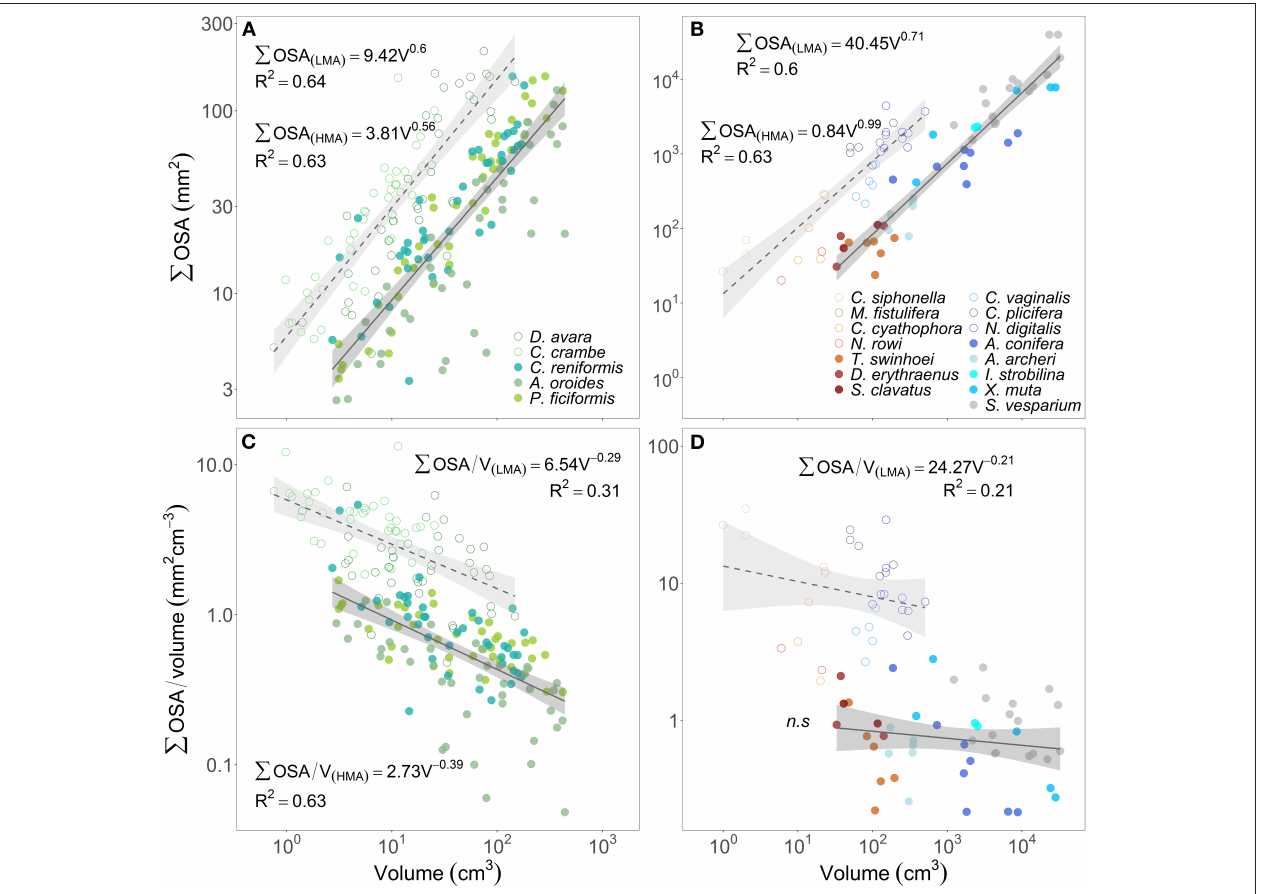
FIGURE 5 | The relationship between the sum of the cross-sectional area of all oscula of each sponge specimen ( P OSA, mm 2 ) and its volume (V, cm 3 ) are plotted in the top panels (A,B) . The lower panels (C,D) show the relationship between the ratio of P OSA to sponge volume (mm 2 cm − 3 ) as a function of sponge volume (cm 3 ). The multi-osculated Mediterranean sponge species are plotted in the left panels (A,C) , the tropical sponges from the Red Sea (reddish color shades) and the Caribbean Sea (blue color shades) are plotted in the right panels (B,D) . For the regression analysis, sponge species were clustered accordingly to host type: HMA (closed symbols, solid regression lines) and LMA (empty symbols, dashed regression lines). The scaling exponents and coefficients calculated for HMA and LMA separately are shown in each panel and the shade areas represent the 95% confidence interval for the regression line. The b scaling exponents were statistically different from zero for all equations ( p < 0.01) except for the tropical HMA species ( n.s , p >